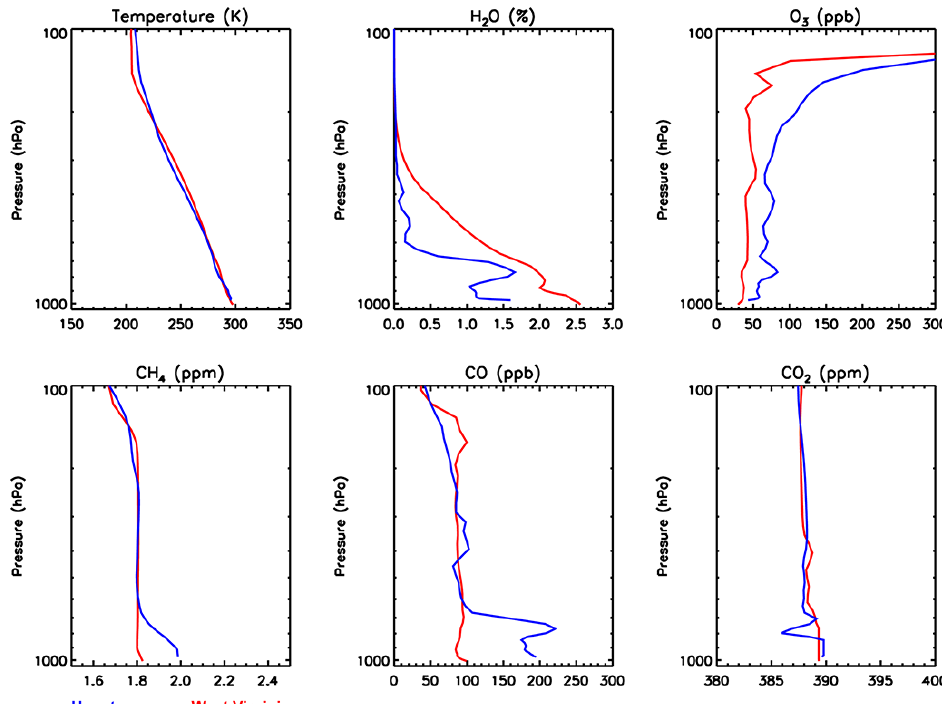
Figure 1. Scenarios considered in the